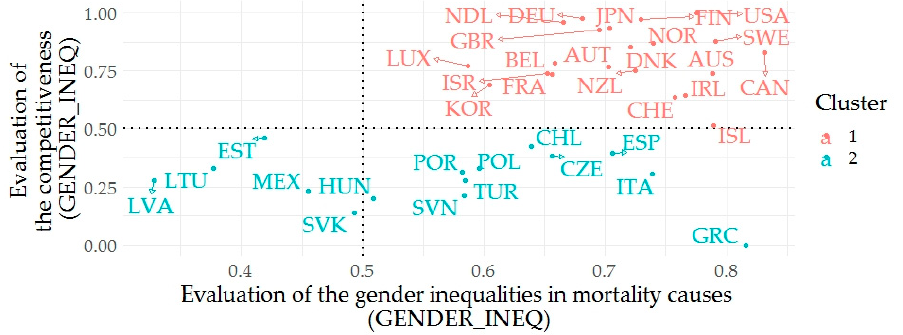
Figure 1. Relation between evaluation of gender inequalities in mortality causes and competitiveness.